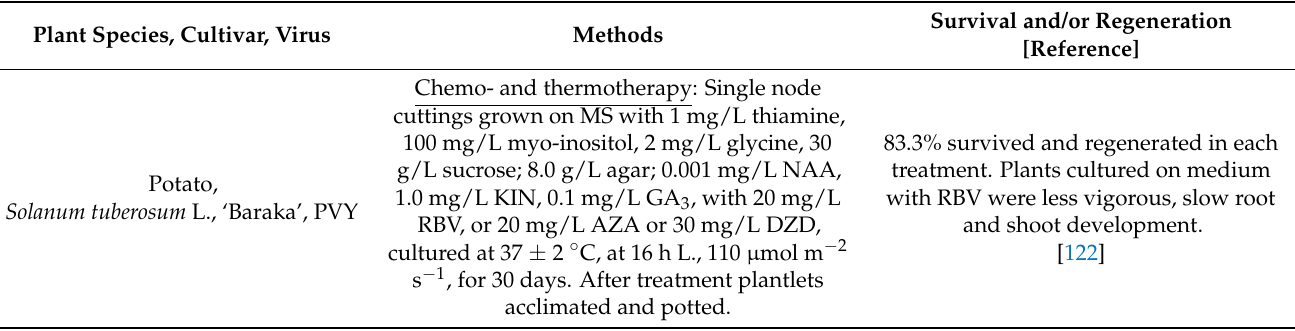
Table 7. Experimental details of combined